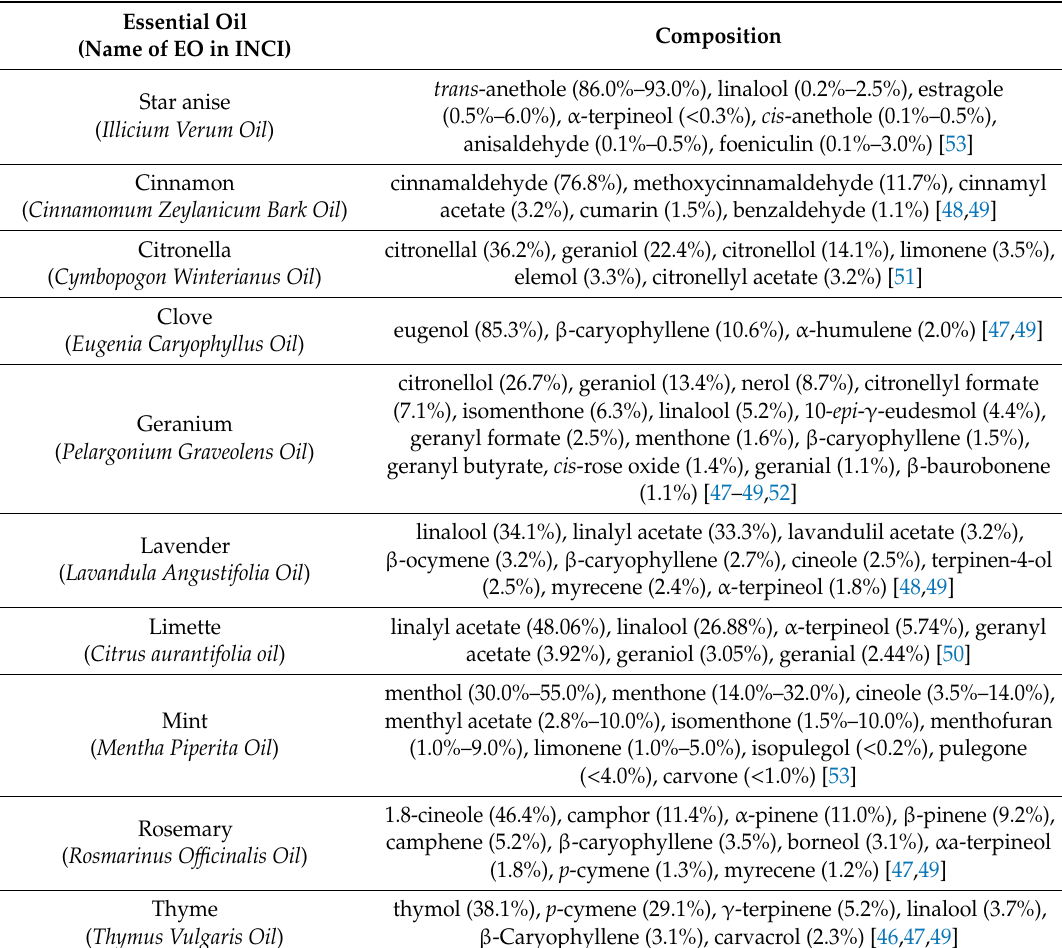
Table 1. Characteristics of essential oils used in the